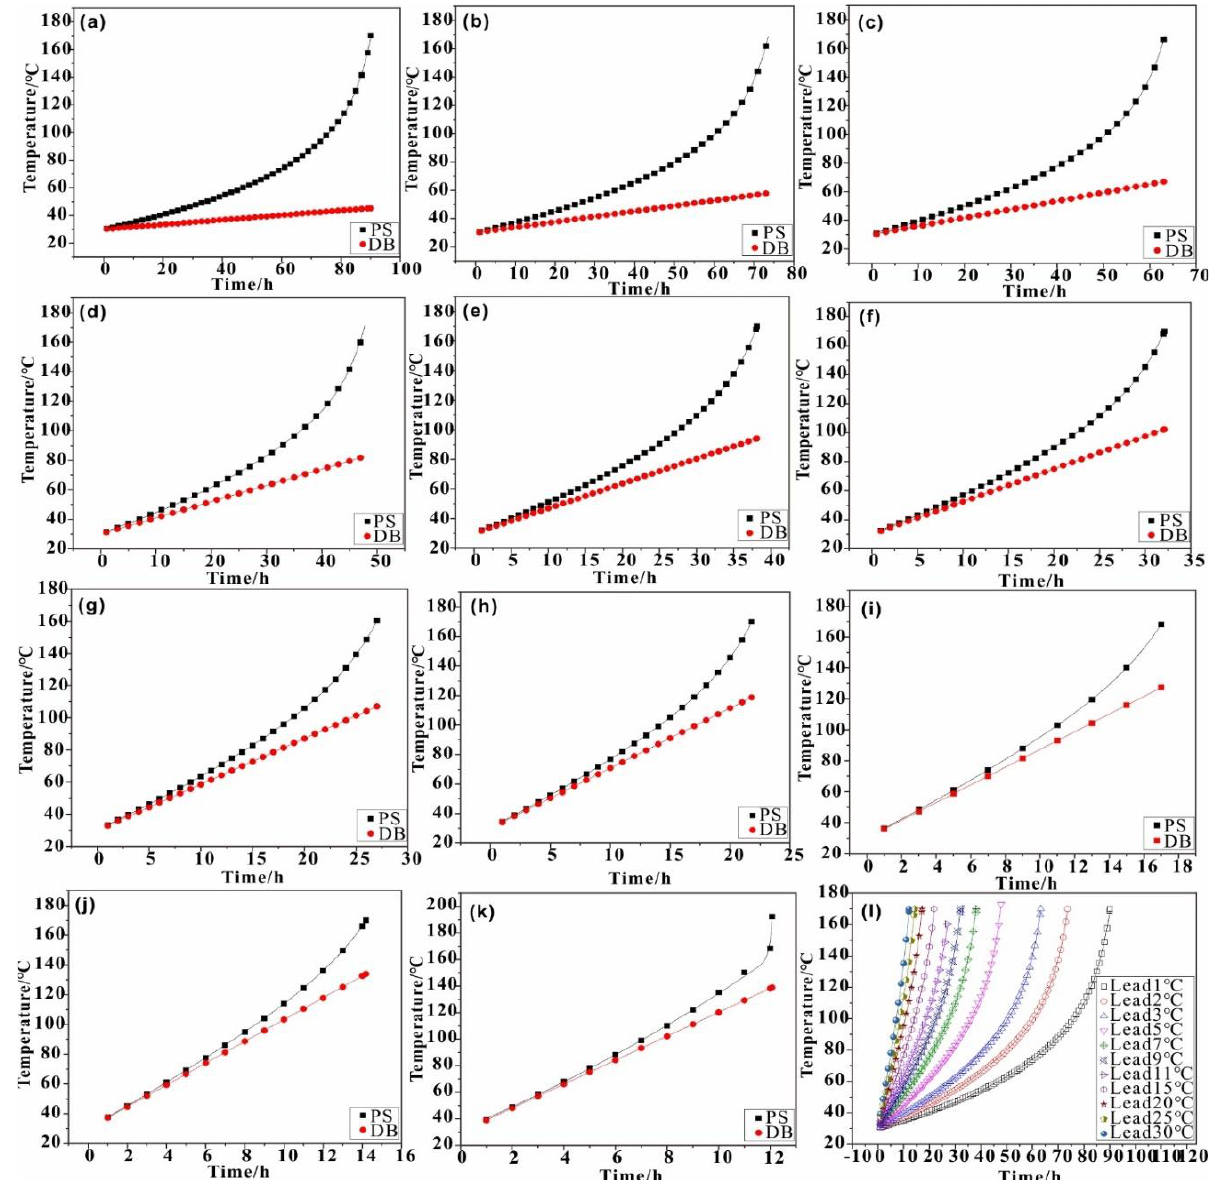
Figure 5. PS and DB lead temperature data fitting curve. ( a – k ) represents different leading temper- atures; ( l ) PS leading the heating curve.